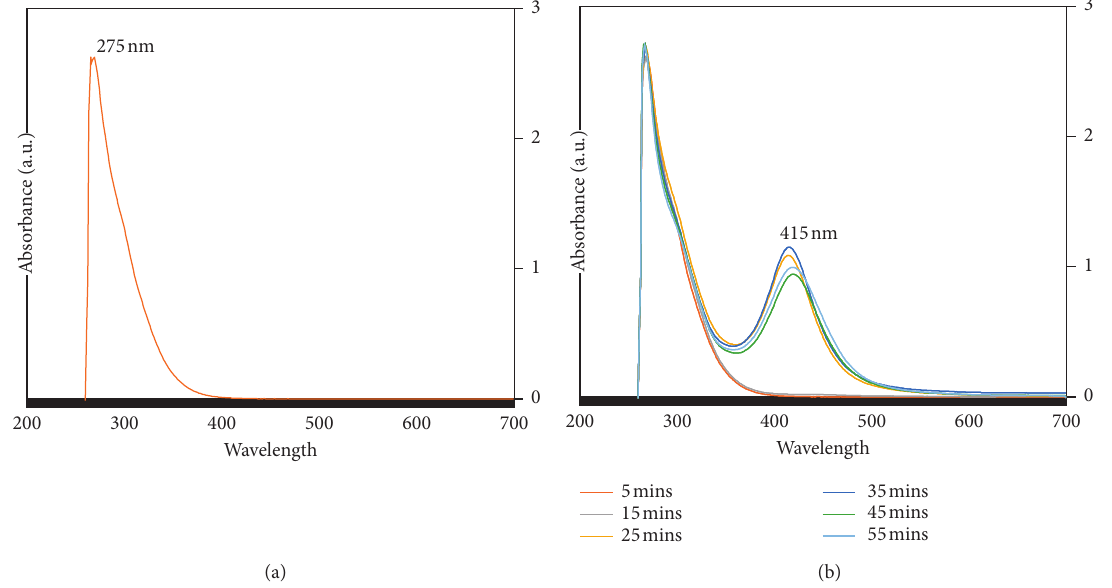
Figure 2: Time evolution of UV-vis absorption spectra of reaction mixture. (a) PAA spectrum (b) AgNPs at 100 ° C.